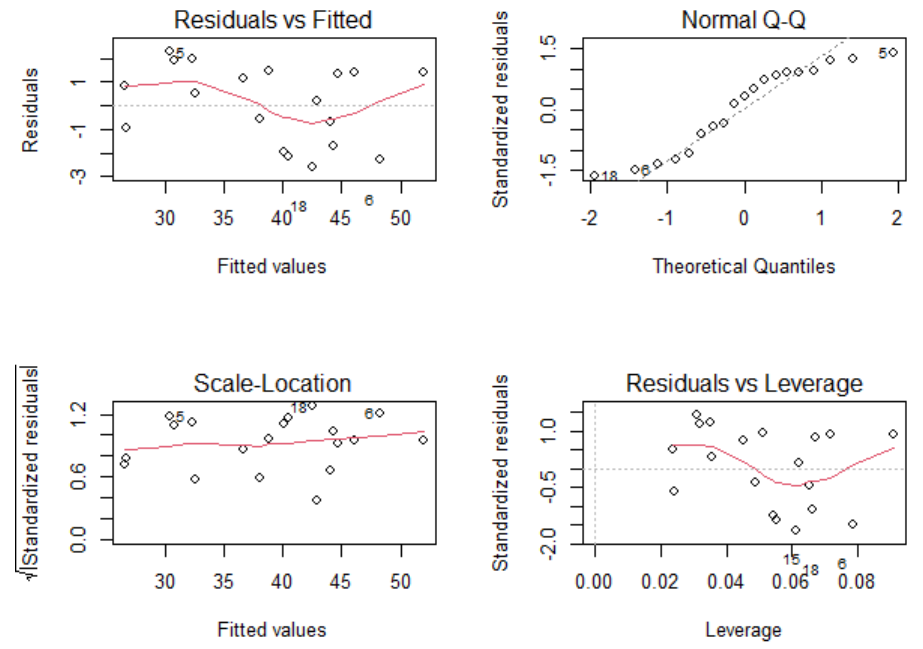
Figure 10. Residual plots generated from the linear regression model in Experiment